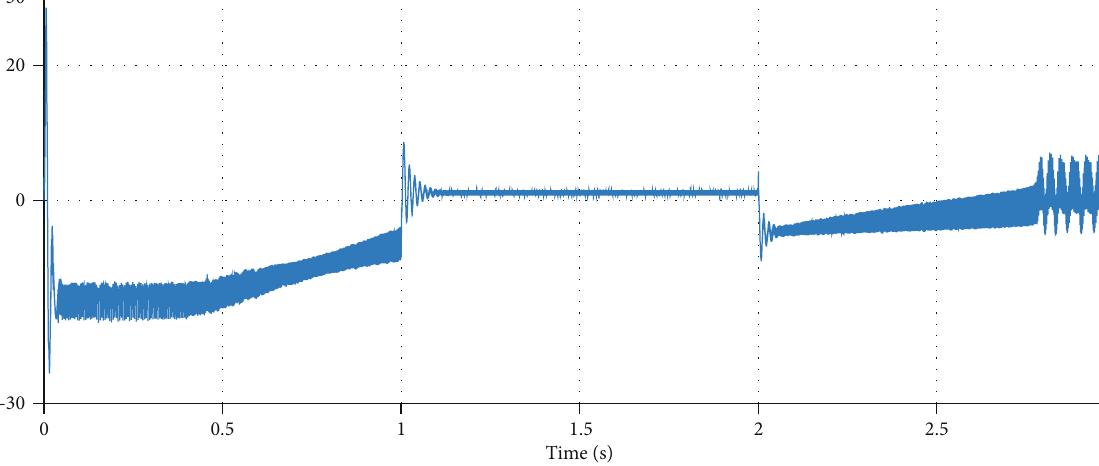
Figure 14: Battery current.